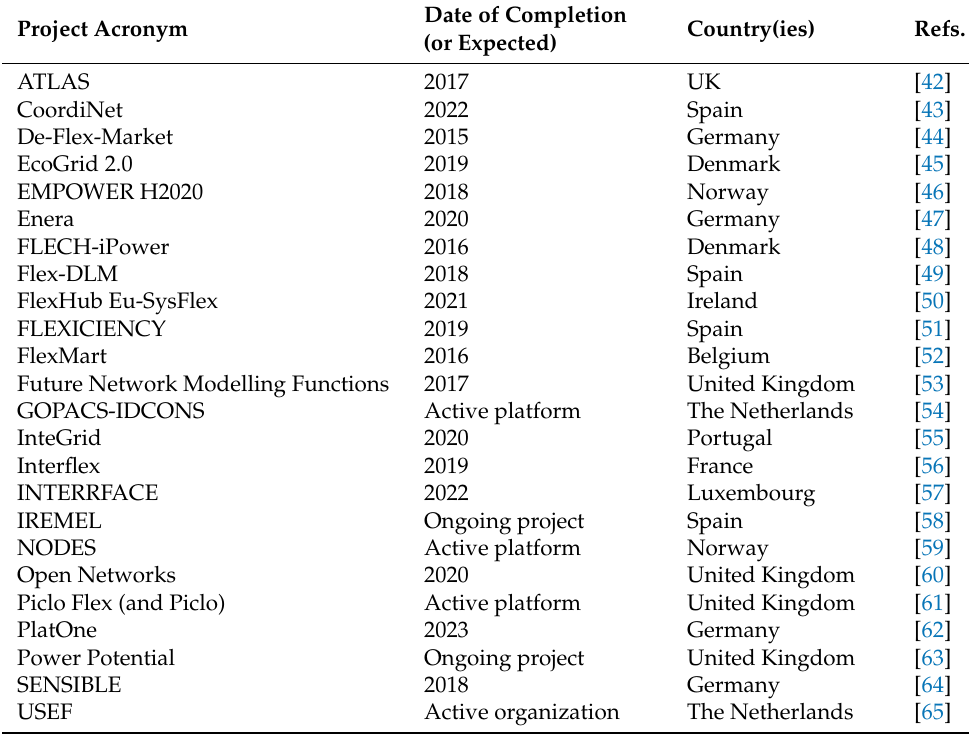
Table 2. List of projects and initiatives